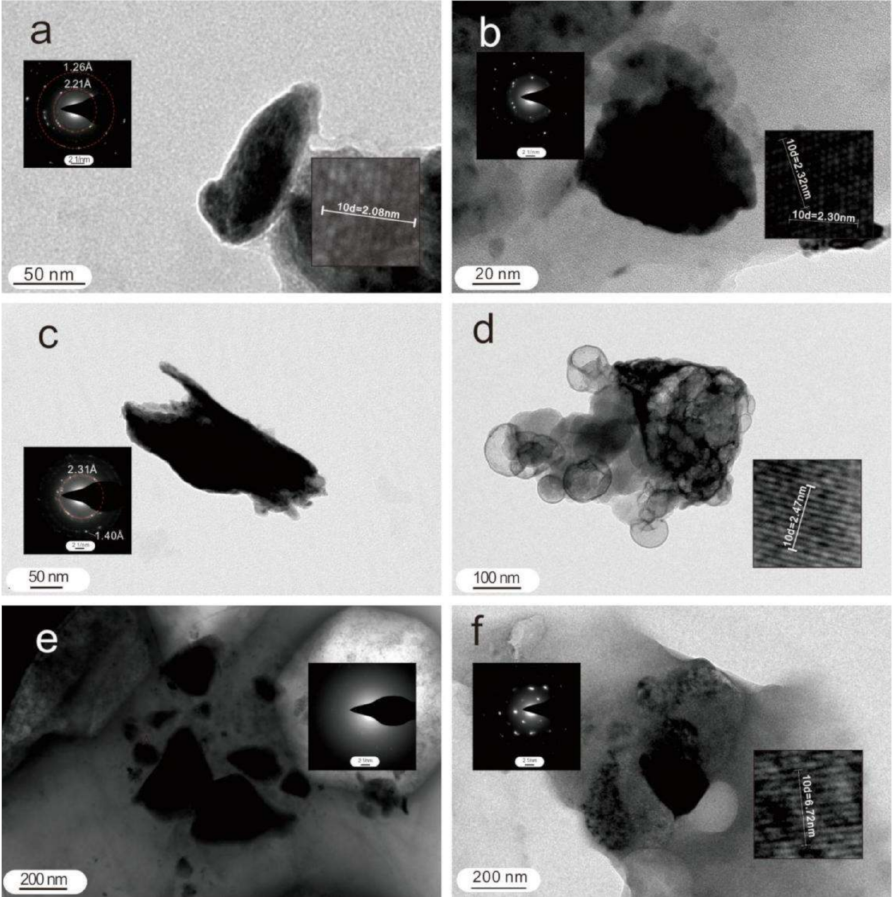
Figure 6. TEM photomicrographs of particles or aggregations carried by the ascending gas flow. ( a ) TEM image, SAED pattern and HRTEM image of an Fe-, Mn- and Cr-bearing particle (ID8). ( b ) TEM image, SAED pattern and HRTEM image of a Cu- and Pt-bearing particle (ID9). ( c ) TEM image, SAED pattern of a Cu- and Sn-bearing particle (ID10). ( d ) TEM image and HRTEM image of a Pb- and Zn-bearing aggregation (ID11). ( e ) TEM image, SAED pattern of several of Fe-, Cu-, Zn- and Bi-bearing particles (ID12). ( f ) TEM image, SAED pattern and HRTEM image of Mo- and Zn-bearing aggregation